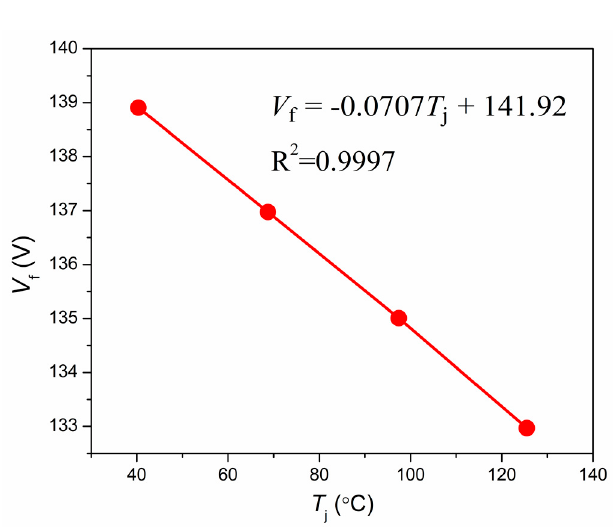
Figure 3. The calibration of junction temperature and forward voltage of LED filament.